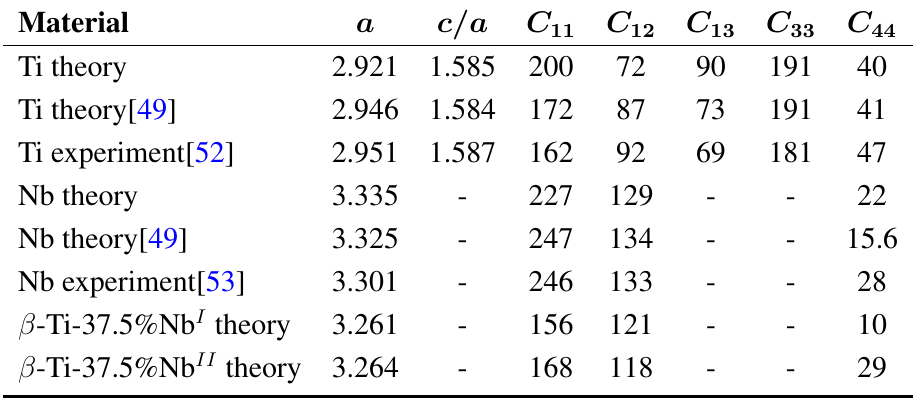
Table 1. Theoretically predicted structural parameters and elastic constants of pure elements Figure 2) compared with available experimental